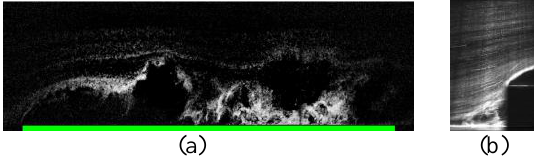
Fig. 3 (a) an example of an instantaneous picture of a qualitative flow visualization (size 2560 × 472 pixels, resolution 0.25 pixel /mm, frame rate 2000 frames/second, exposure time 500 μs); (b) an example of a high-resolution visualization of the retaining vortex formed before the obstacle's front ledge (size: 384 × 944 pixels, resolution: 0.166 pixels/mm exposure time 1.25 ms).